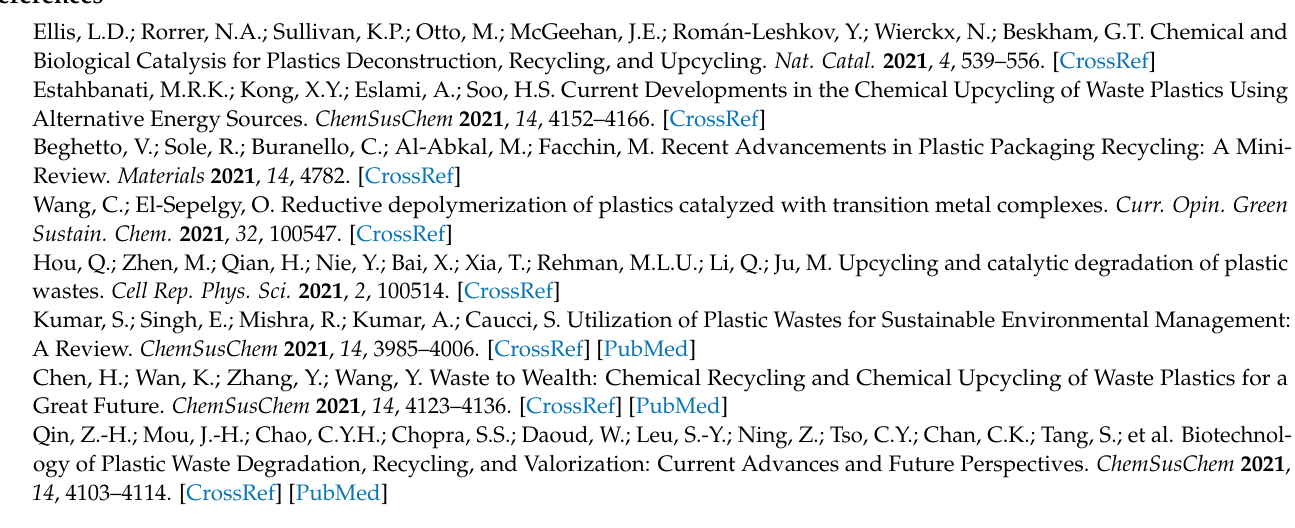
Figure S4: 13C NMR spectrum of busulfan in CDCl3, Figure S5: HPLC-HRMS analysis of a sample of Busulfan. (Ref. [46] cited in the supplementary